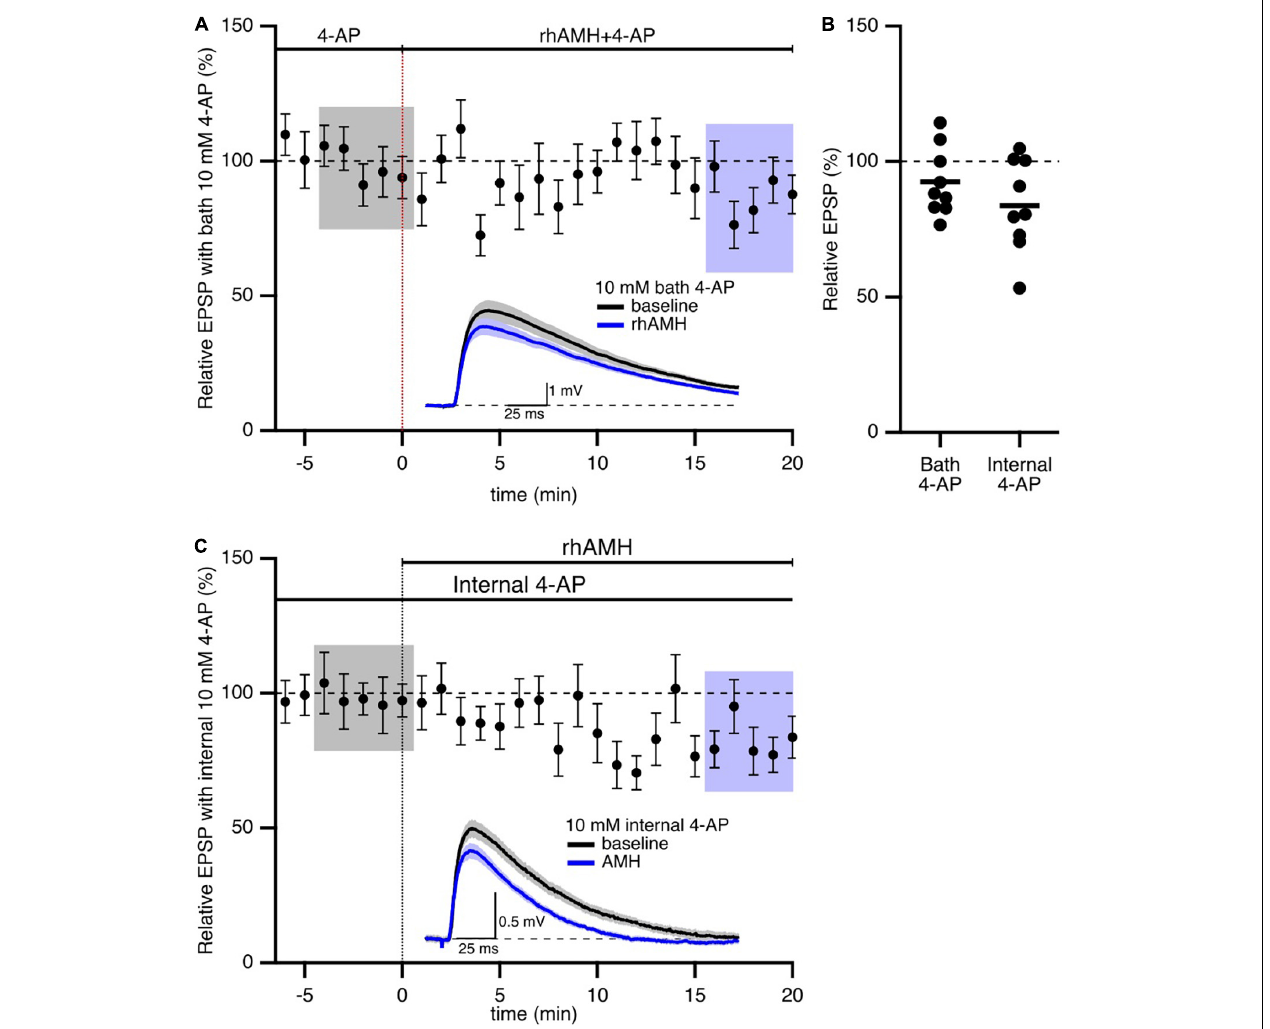
FIGURE 6 | Anti-Müllerian hormone boosting of synaptic responses requires the 4-aminopyridine (4-AP)-sensitive, Kv4.2-containing channels. (A) Summary time course plots of normalized evoked EPSP amplitudes in the presence of 10 mM 4-AP in the bath and bath application of 0.4 nM rhAMH at 0–20 min. rhAMH addition did not increase EPSPs in the presence of 4-AP. Data are binned into 1 min intervals, mean ± SEM. Representative voltage traces (average of 15 EPSPs) were acquired in the absence (black) and presence (blue) of rhAMH for individual neurons. (B) Summary scatterplot of normalized EPSP amplitude. (C) Summary time course and representative traces in the presence of 10 mM 4-AP in the patch pipette internal solution. Following whole cell formation cells were dialyzed for 20 min before evoking